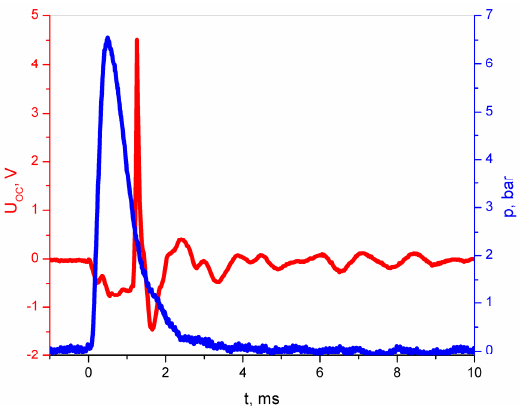
Figure 6. Open-circuit voltage of the epoxy resin/SbSI nanowire generator induced by shock pressure (red curve). The blue curve represents the pressure change of the CO 2 shock wave.